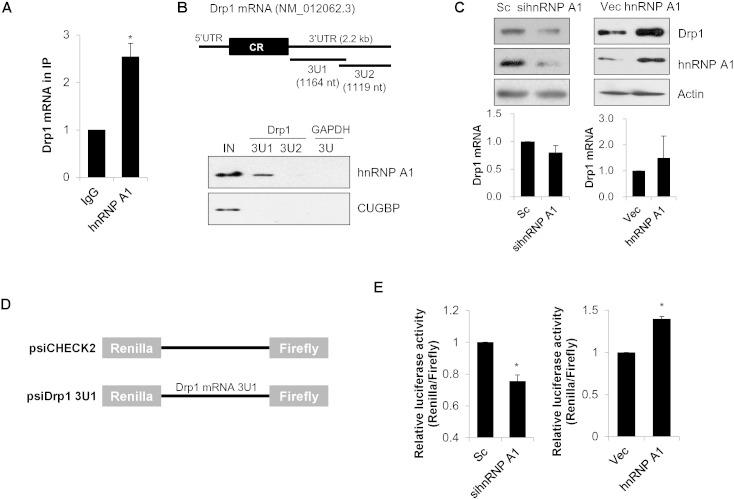
hnRNP A1 regulates Drp1 expression by binding its 3′UTR.(A) SH-SY5Y cell lysates were subjected to RNP-IP complex using anti-hnRNP A1 antibody or control IgG. After isolation of RNAs in the precipitated complex, relative binding of Drp1 mRNA to hnRNP A1 was assessed by RT-qPCR. (B) Schematic description of the Drp1 mRNA (NM_012062) 5′-untranslated region (5′UTR), coding region (CR), 3′-untranslated region (3′UTR). The interaction between hnRNP A1 and biotinylated transcripts of Drp1 mRNA 3′UTR was examined by biotin-pull-down analysis. After incubating biotinylated fragments with cell lysates, the binding was analyzed by Western blotting using hnRNP A1 antibody. GAPDH 3′UTR (GAPDH 3U) was used as a negative control. (C) SH-SY5Y cells were transfected with either hnRNP A1 siRNA (sihnRNP A1, left) or pHA-hnRNP A1 (hnRNP A1, right), and the protein levels were analyzed by Western blotting with indicated antibodies (upper panel) and Drp1 mRNA was measured by RT-qPCR (lower panel). (D) Schematics of luciferase reporter plasmid containing 3U1 fragment of Drp1 mRNA (psiDrp1 3U1) and control plasmid (psiCHECK2). (E) Relative reporter activity was assessed by luciferase assay after transfection either siRNAs or plasmids in SH-SY5Y cells. Renilla luciferase activity was normalized with firefly luciferase activity. Data are represented as the mean ± SEM (n = 3, and * p < 0.05 value).